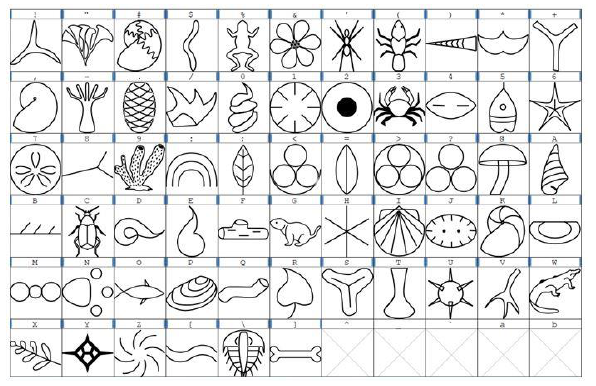
Figure 10 . Glyphs compiled in the font file